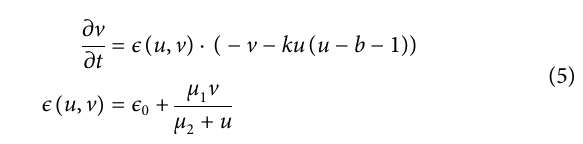
Frontiers in Applied Mathematics and Statistics |